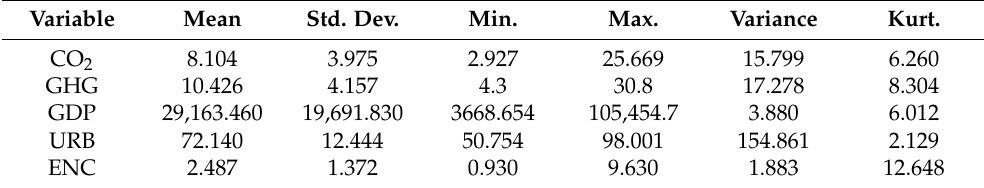
Table 2. Summary